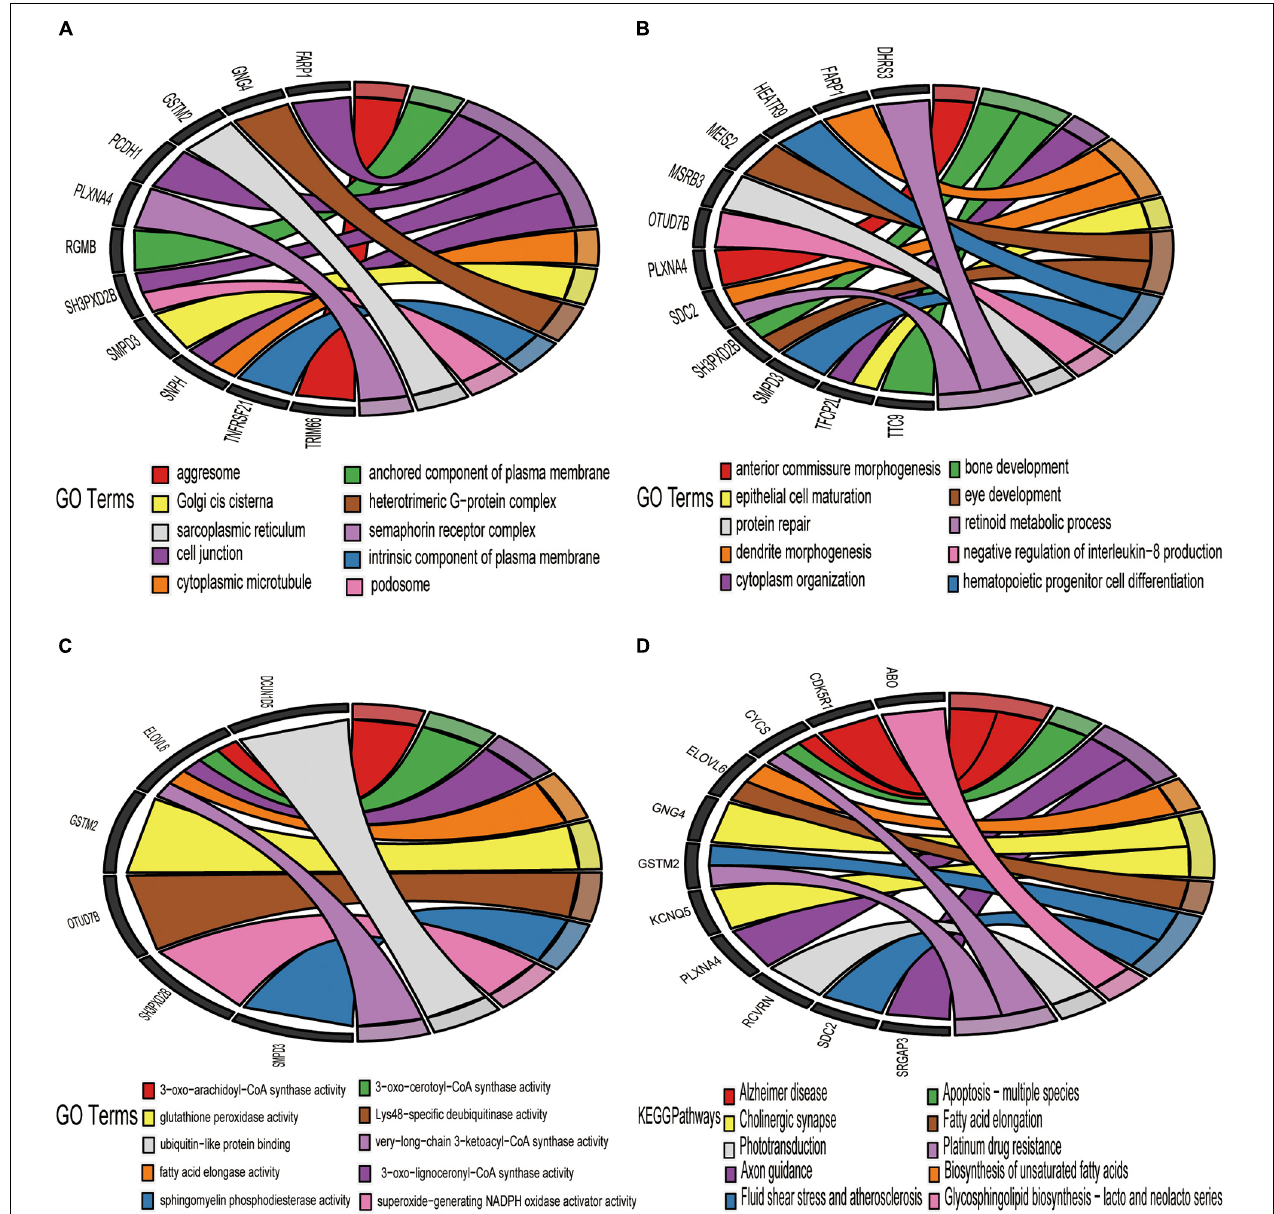
FIGURE 7 | Enrichment analysis of 44 downregulated target DE-mRNAs. Chord plots was used to visualize the enrichment analysis of these DE-mRNAs. (A) GO item cellular CC analysis. (B) GO item Bp analysis. (C) GO item MF analysis. (D) KEGG pathway analysis. The thresholds were a | log2FC| ≥ 0.58 and P -value ≤